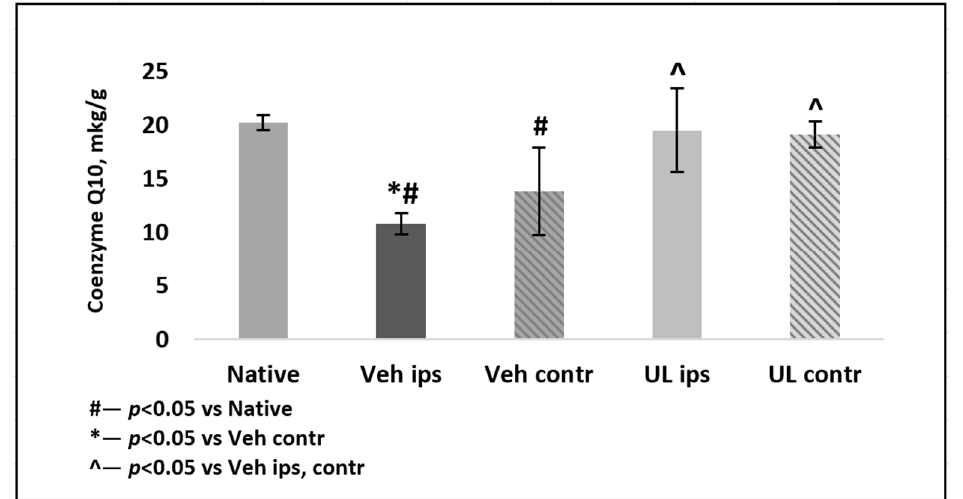
Figure 6. Coenzyme Q10 brain level measured by HPLC four days after middle cerebral artery occlusion. Groups: Veh–MCAO + Vehicle; UL–MCAO + Ubiquinol; Native. Contr—contrlatheral hemisphere; Ips—ipsilatheral hemisphere.